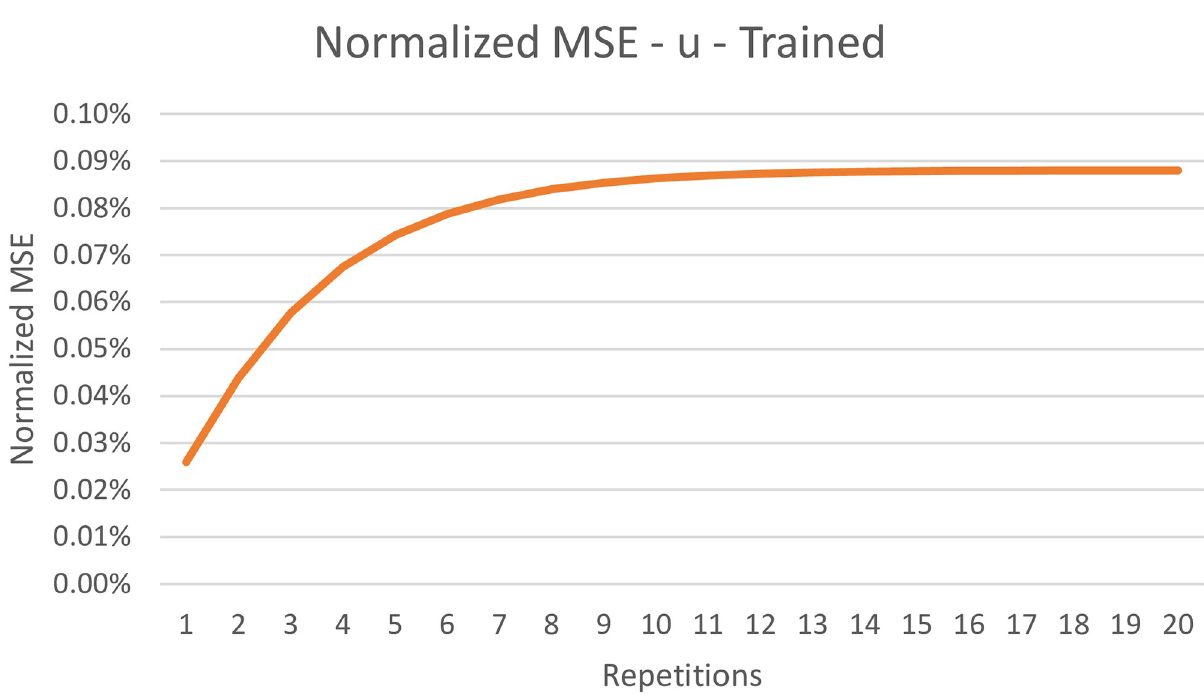
Fig 4. Normalized RMSE of motor command after training. Normalized root mean-square error (RMSE) in motor command output of TorchDIVA vs DIVA over 20 repetitions with a trained speech target ‘u’.